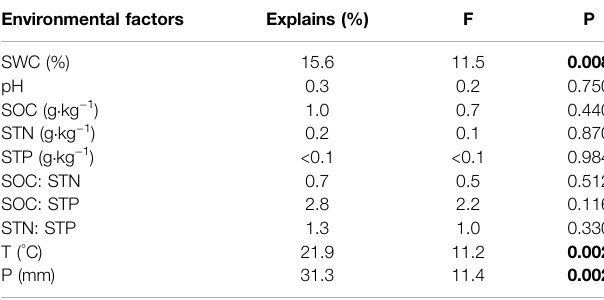
TABLE 3 | Level of explanatory capacity and signi fi cance of environmental factors in the variation of L. virgaurea leaf ecological stoichiometry at different